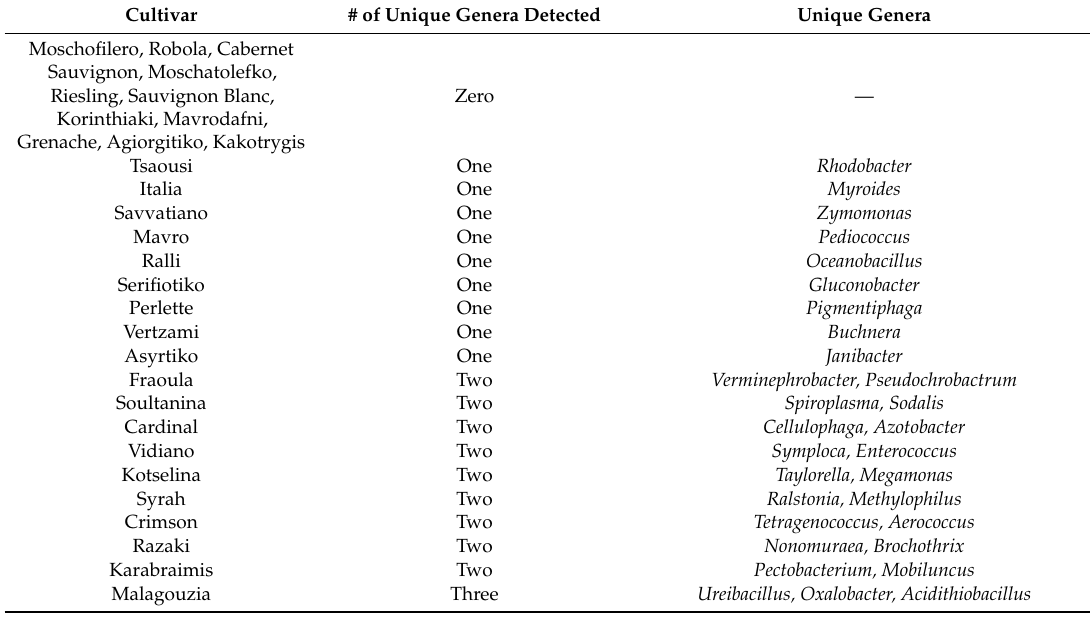
Figure 4. Hierarchical Cluster constructed using Bray-Curtis at the genus level for 37 grapevines. 12